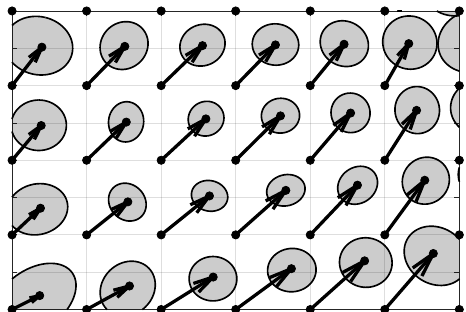
Figure 1. Combination of a vector field and an uncertainty field showing the transformations and the resulting uncertainty of error-free, equally spaced lattice points mapped by an uncertain